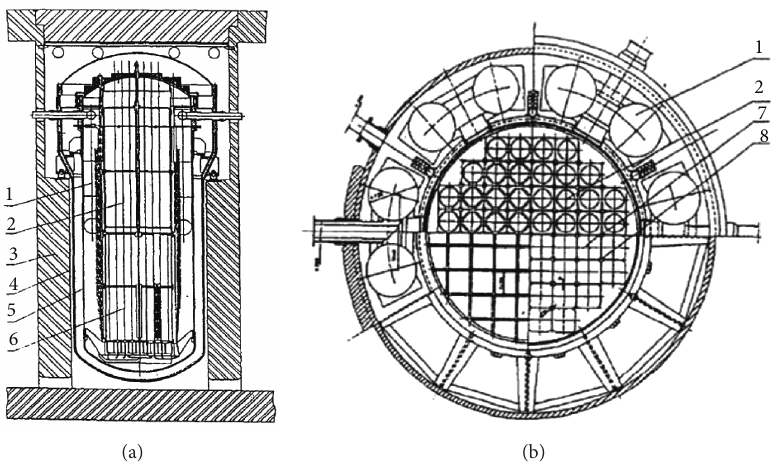
Figure 1: Structure and cross-section of the NHR-200: 1: primary heating exchanger, 2: riser, 3: biological shield, 4: containment, 5: pressure vessel, 6: core, 7: fuel elements, 8: control